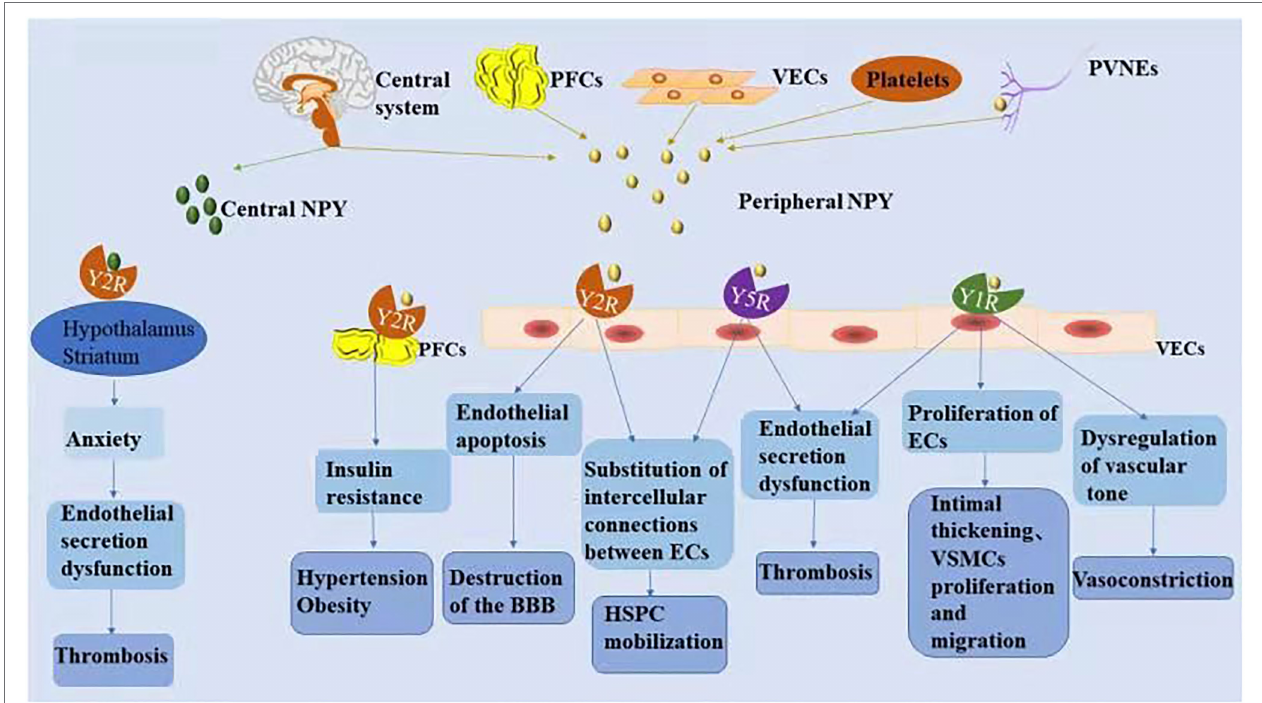
FIGURE 2 | The mechanism associated with NPY-induced endothelial injury. Increased NPY level in the central and/or peripheral nervous systems is directly and indirectly involved in the process of vascular ED. NPY activates different receptors to perform various physiological